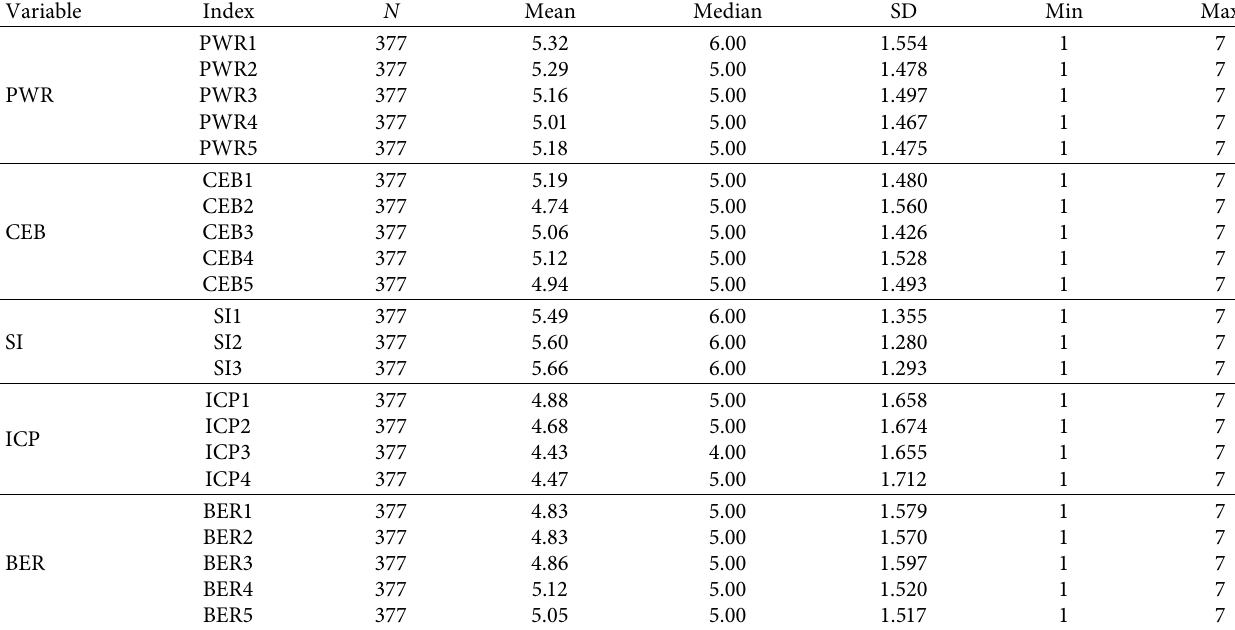
Table 3: Descriptive statistical